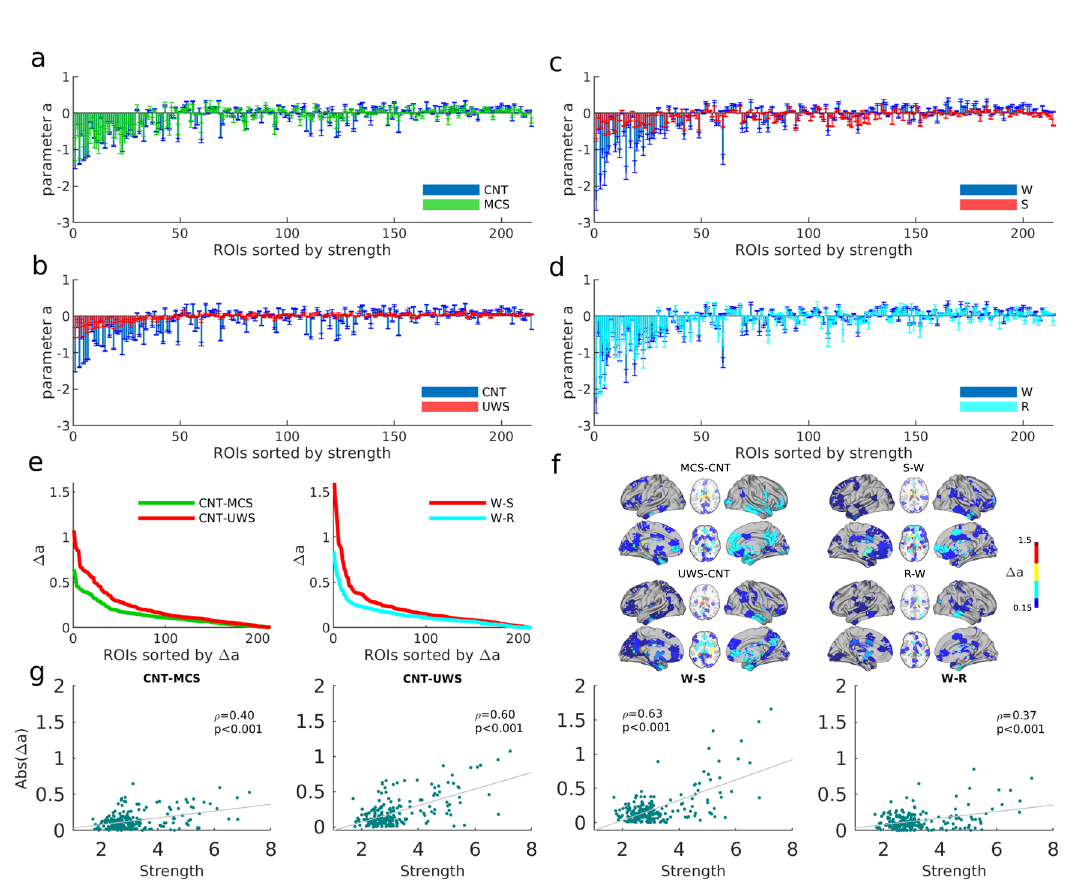
Fig. 3 Local bifurcation parameters of the whole-brain model. a – d Estimated bifurcation model parameters a for each of the 214 nodes (sorted by node strength). Bars indicate the mean ± standard deviations across simulation trials. Results for low-level states of consciousness (MCS and UWS) are compared against the healthy controls in a and b. Results for anaesthesia and recovery (S and R states) are compared to the initial awake state (W) in c and d respectively. e Ranked absolute parameter difference, Δ a, for all the comparisons. f Spatial distribution of Δ a > 0.15 in the brain for each of the group comparisons. g Relationship between the absolute difference Δ a and the strength of each node. The absolute difference of the parameter a values between different groups as a function of the strength of the nodes extracted from the SC of the healthy controls. ρ corresponds to the Pearson